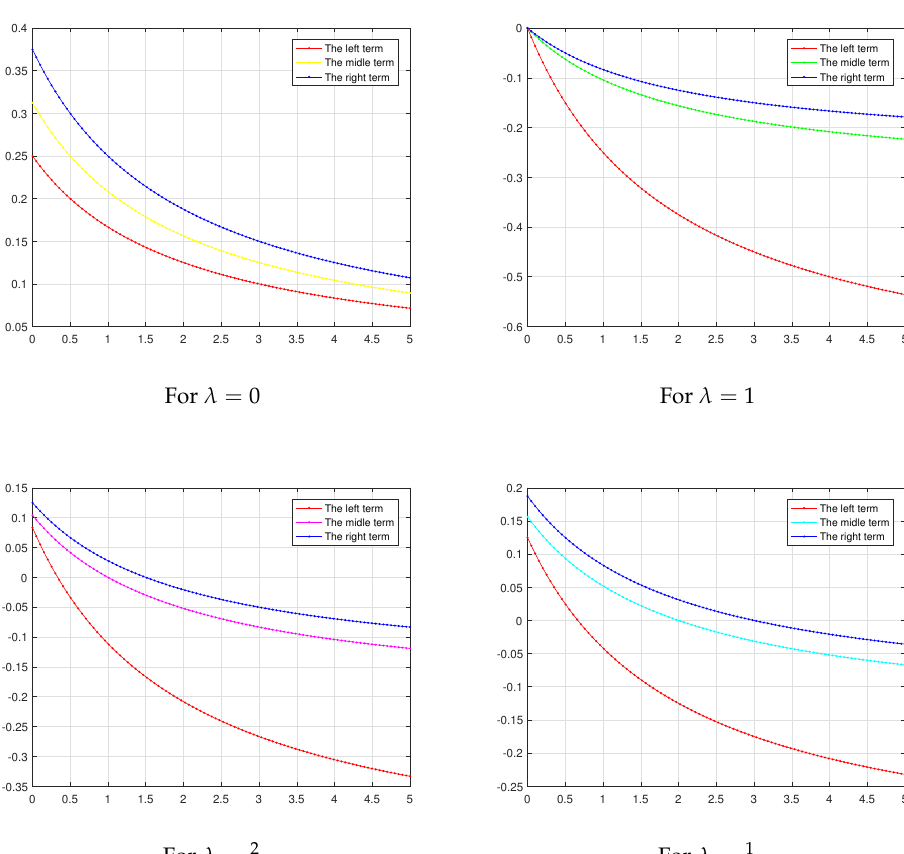
Figure 2. Graph of both sides of (12) in Example 2, depending on α and λ , evaluated and drawn with